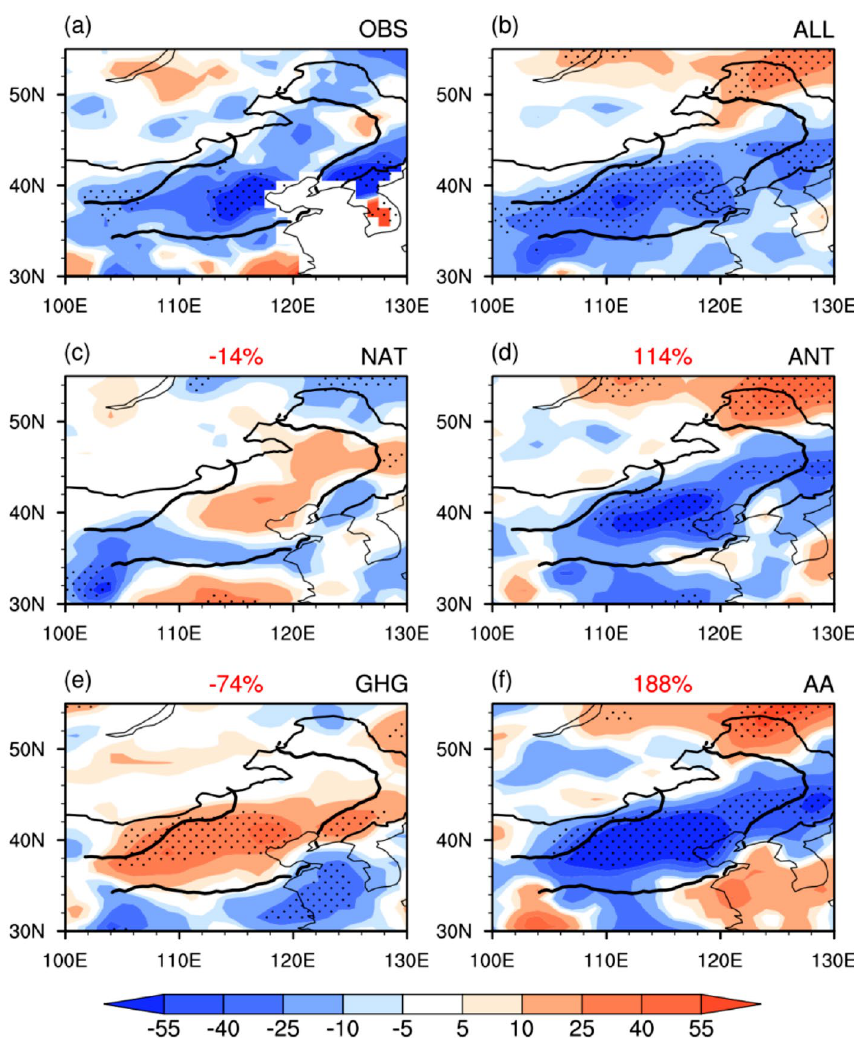
Figure 3. Linear trends of precipitation (unit: mm month −1 55 yr −1 ) in August during 1951–2005. ( a ) Observational precipitation trend averaged between CRU TS version 4.01 21 (URL: http://cruda ta.uea.ac.uk/ cru/data/hrg/cru_ts_4.01/) and GPCC V7 22 (URL: https ://psl.noaa.gov/data/gridd ed/data.gpcc.html). The multimodel ensemble simulations of ( b ) historical run, ( c ) natural forcing run, ( d ) anthropogenic forcing run, ( e ) GHG forcing run, and ( f ) aerosol forcing run. Regions covered with dots feature linear trends significant at the 90% confidence level. The black curves indicate the boundary of the TCZ domain. The numbers at the center-top of the figures denote the relative contribution percentages of the corresponding external forcings. This Figure is created by the NCAR Command Language (version 6.4.0 & URL: http://www.ncl.ucar.edu/Downl oad) 27